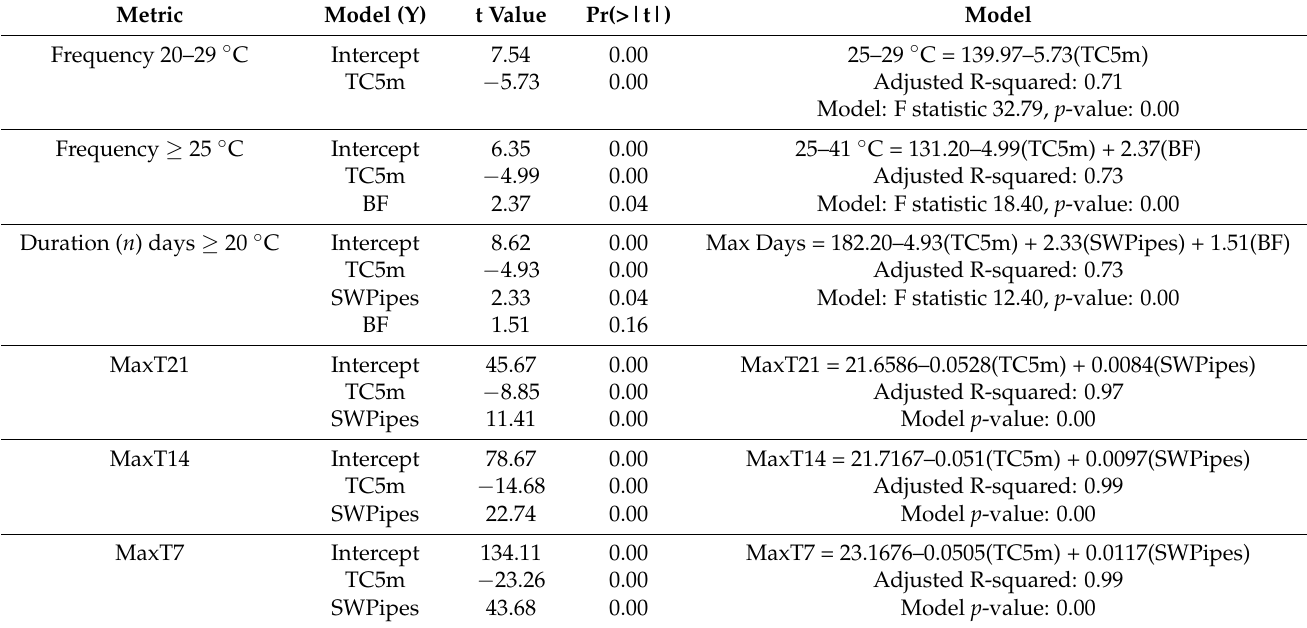
Table 5. Mixed-effects models to predict water temperature metrics based on April to October 2016 data for 14 study sites. The selected metrics are designed to quantify frequency and duration of exceedance of thermal stress thresholds and magnitude of thermal change for aquatic species in urban streams with 4 to 62% impervious land cover. The models listed in this table are the final, best fit model to predict each metric after testing 6 candidate models per metric. The best fit predictive models for frequency of exceedance of thermal stress temperatures include baseflow (BF) and % tree canopy in 5 m riparian areas (TC5m) variables. The best fit predictive model for duration (Max days ≥ 20 ◦ C) included BF, TC5m, and total length of stormwater pipes per loggershed (SWPipes). The best fit predictive models for magnitude of change (MaxT21, MaxT14, MaxT7) included TC5m and